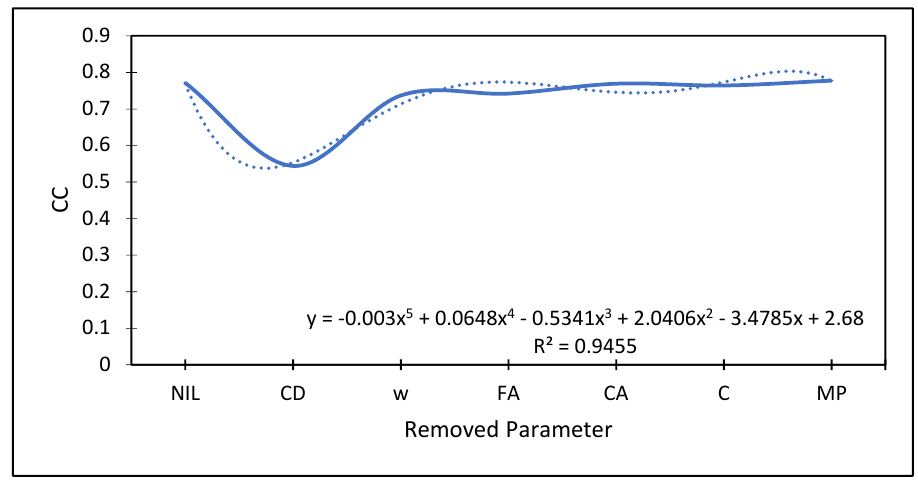
Figure 13. Relationship between Removed Parameters and CC Value Based on GP Model. Table 13. GP-based sensitivity model results for FS < 10 and FS > 10.